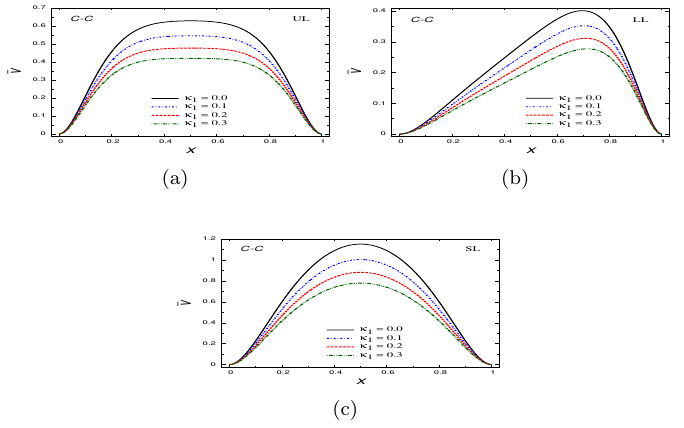
Figure 8. Effect of Winkler’s parameter κ 1 on of the distribution of angular displacement along the axial direction of a C-C CNT subjected to: (a) UL, (b) LL, and (c) SL.